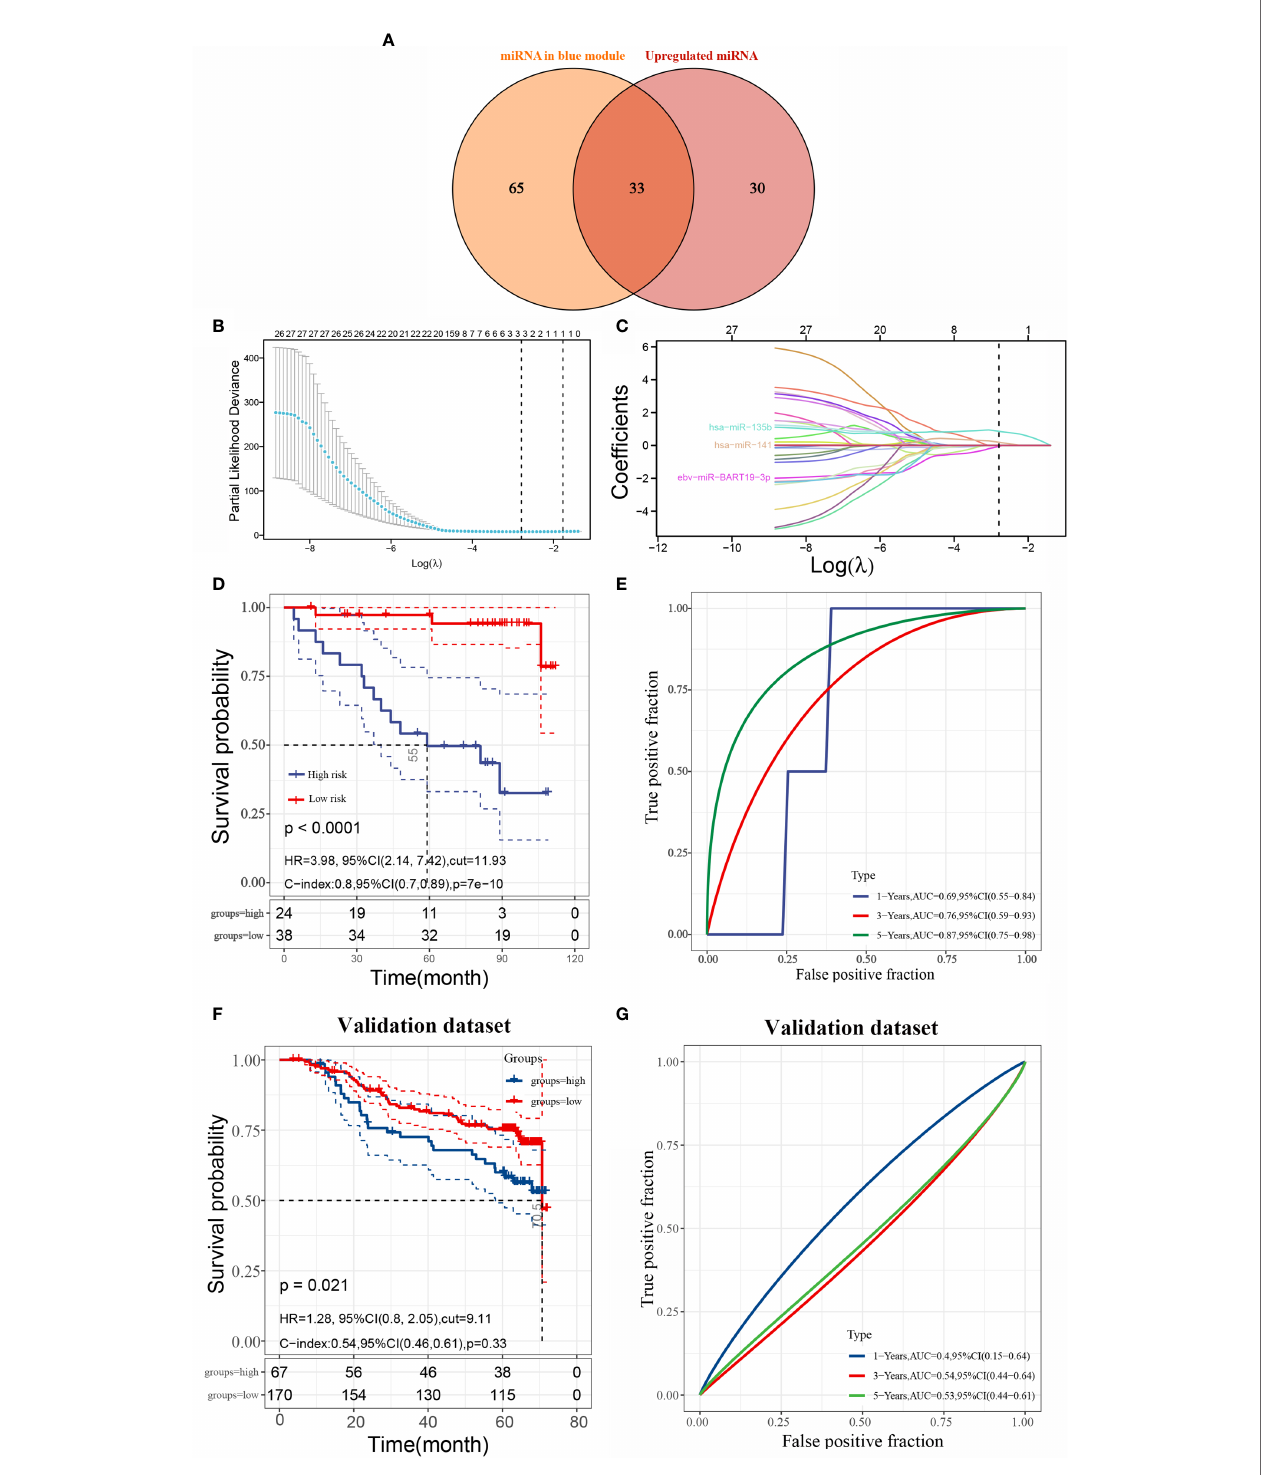
FIGURE 3 | Identi fi cation of hub miRNAs and construction of survival prognosis prediction model (A) intersection of differentially upregulated miRNAs and miRNAs from the blue module; (B) lasso coef fi cient screening; (C) trajectory plot of lasso variables; (D) Kaplan-Meier curves of overall survival (OS) derived from risk scores of three miRNA features in the training set; (E) comparison of risk scores of three miRNA markers in the training set for predicting 1-, 3-, and 5-year ROC curves for survival; (F) Kaplan-Meier curves for overall survival (OS) derived from the risk scores of the three miRNA signatures in the validation set; (E) ROC curves comparing risk scores of three miRNA markers in the validation set for predicting 1-, 3-, and 5-year survival).